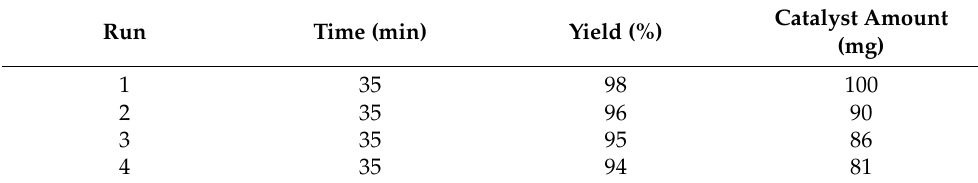
Table 7. Recyclability studies of 50% Al 2 O 3 catalyst a under solar heat.